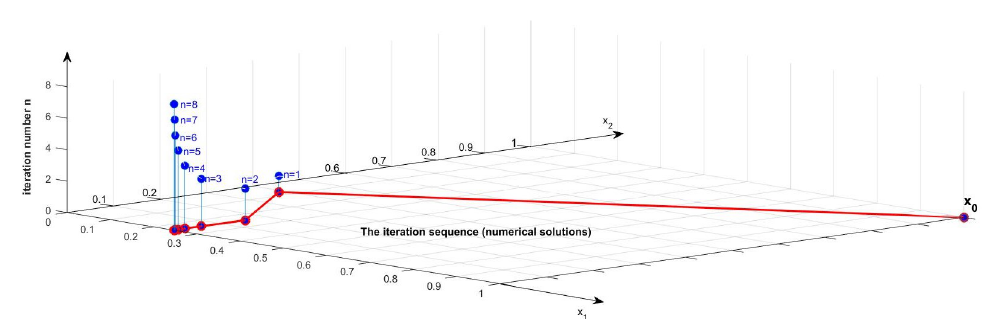
Figure 1. The approximation sequence for the initial estimation x 0 = ( 1,1 )